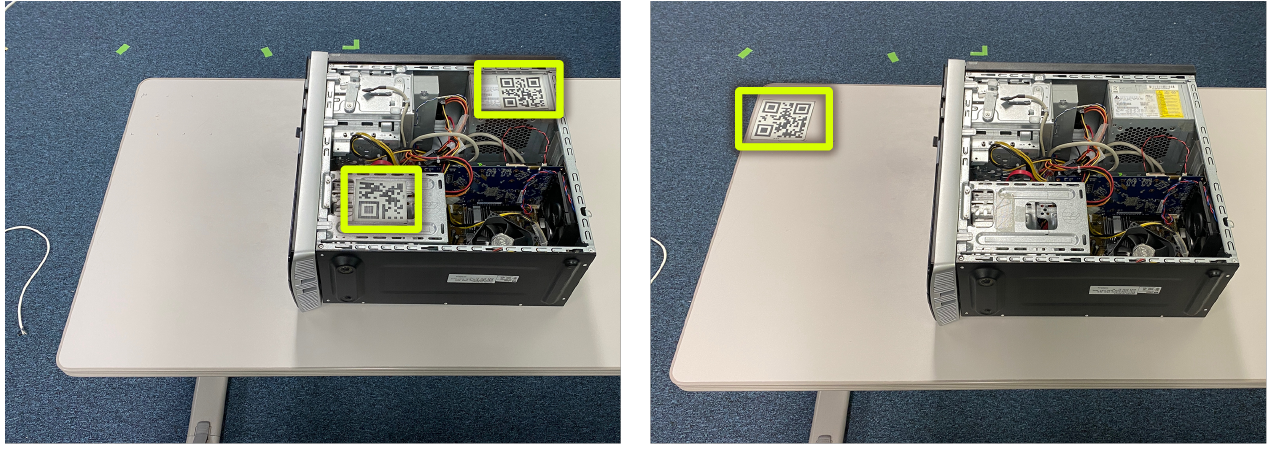
Figure 32. ( a ) The engine has two markers attached to different parts to ensure that objects are tracked throughout the entire process. ( b ) There is no marker on the PC, and the marker on the table is